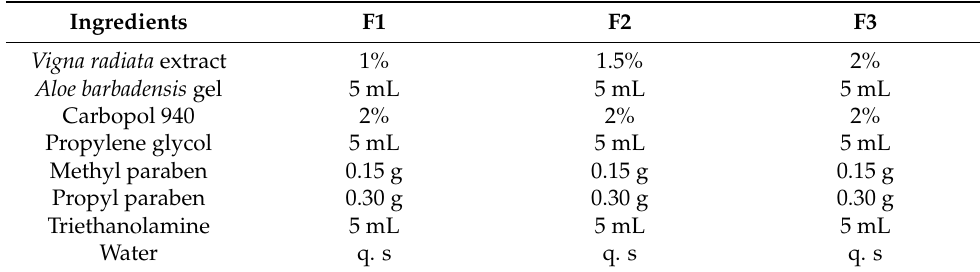
Table 5. Formulation of polyherbal